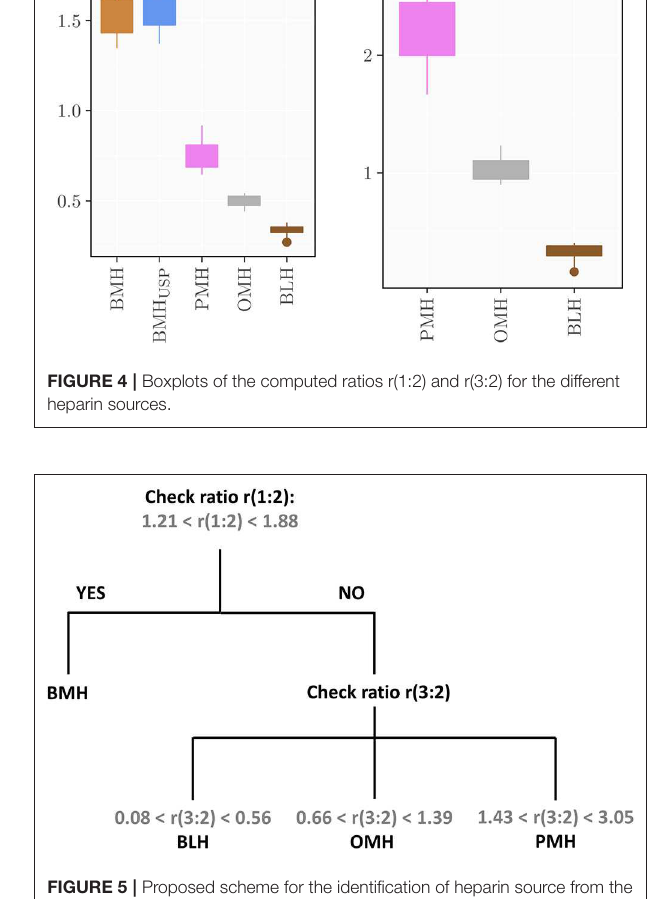
FIGURE 5 | Proposed scheme for the identification of heparin source from the signal ratios r(1:2) and